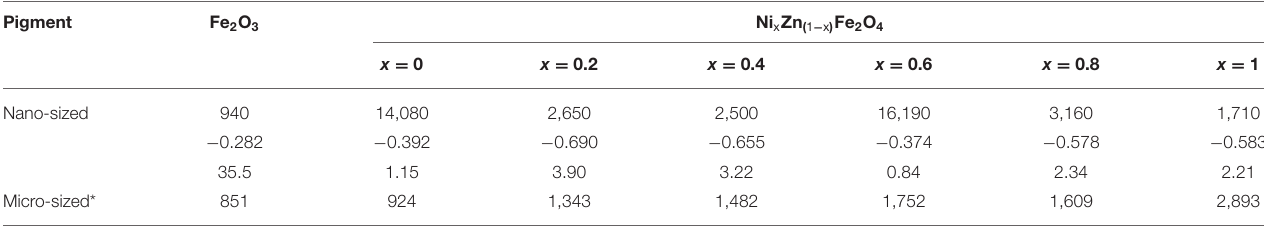
TABLE 1 | The polarization resistance (in Ω cm 2 ), corrosion potential (in V vs. SCE) and the corrosion current density (in µ A/cm 2 ) of carbon steel electrode determined in Fe 2 O 3 and nano-sized ferrite